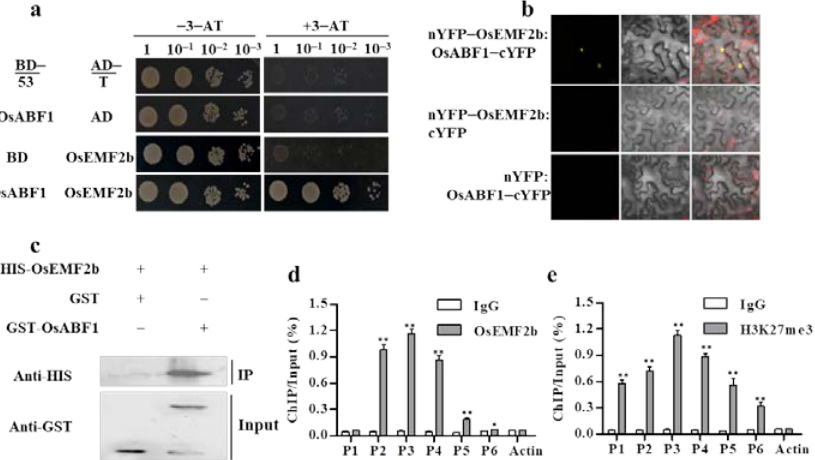
Figure 4. OsABF1 recruits PRC2 complex to target loci by interacting with OsEMF2b. ( a ) Yeast two-hybrid assay showed OsABF1 interaction with OsEMF2b in yeast. Yeast cells co-transformed with OsABF1-BD and OsEMF2b-AD were grown on SD-Trp/-Leu/-Ade/-His selective medium with 3 mM 3-AT (a competitive inhibitor of the HIS3 gene product). ( b ) BiFC was used to detect the interaction between OsABF1 and OsEMF2b. The tested protein pairs were constructed in vector pDOE-BiFC and transiently expressed in tobacco leaf epidermal cells. Positive interactions are indicated by the visualization of YFP fluorescence, scale bar = 20 µ m. ( c ) In vitro pull-down assay. Purified His-OsEMF2b and GST-OsABF1 were subjected to pull-down assays and detected with anti-His and anti-GST antibodies, respectively. ( d , e ) ChIP-qPCR analysis of OsEMF2b and H3K27me3 deposition on SD1 target loci in OxABF1-6 . Values are means ± SD ( n = 3). * p < 0.05, ** p < 0.01 by Student’s t -test